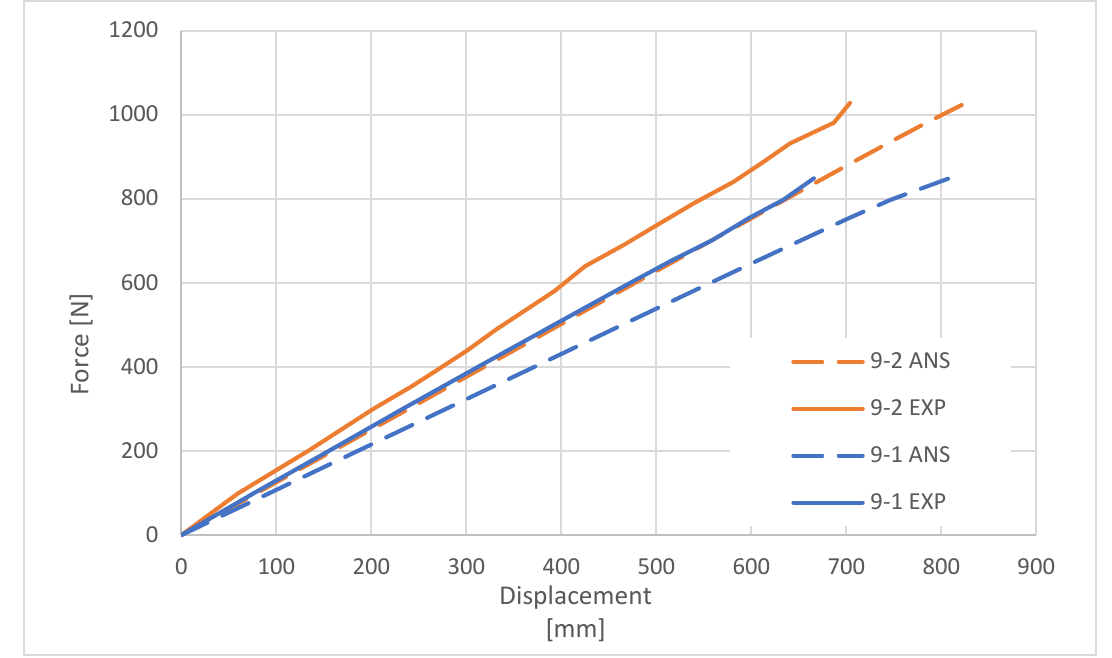
Figure 8. Load – deflection curves for 9 m long poles.